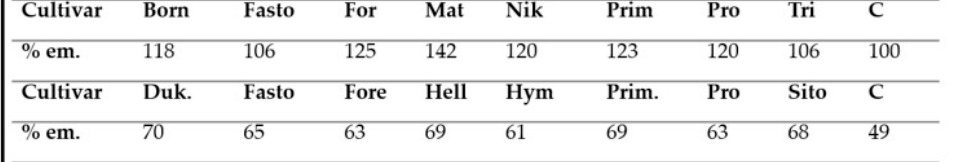
Figure 1. ( A , B ): Preparation of rye mulches at the Università Cattolica del Sacro Cuore research station in Piacenza, Italy. ( C ): Rye mulch covered and control planter boxes for velvetleaf germination experiments in the greenhouse. ( D , E ): Emergence of velvetleaf seedlings (white circles) in pots with rye mulch ( E ), only seedlings overtopping the rye mulch cover are circled) in comparison to the control ( D ). ( F ): Flowering velvetleaf plant in a maize field. Table—Abbreviations: % em: percentage of emerged velvetleaf seedlings; cultivars: For, Forestier; Mat, Matador; Nik, Nikita, Prim, Primizia; Pro, Protector; Tri, Treviso; Duk, Dukato; Fore, Forestal; Hell, Hellvus; Hym, Hymonta; Sito, Sito70; C: control.